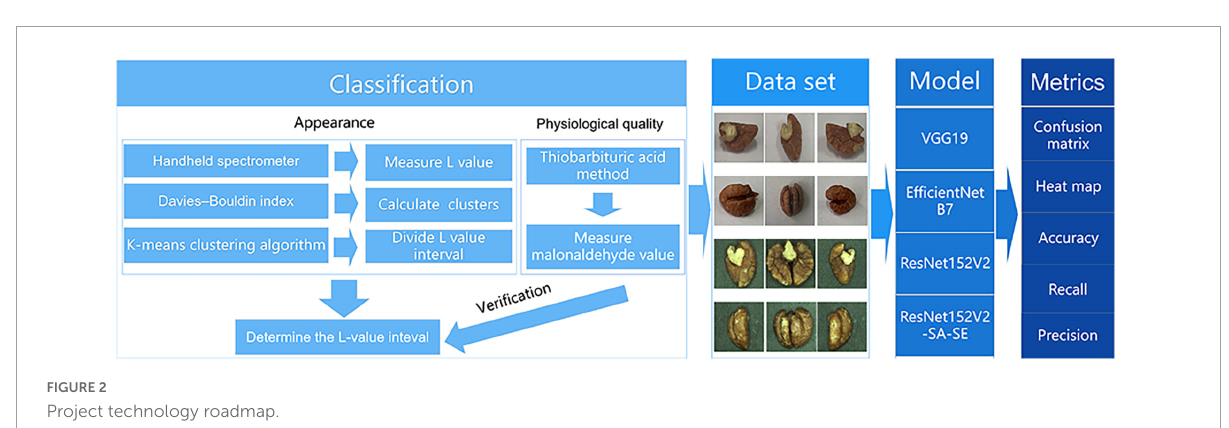
FIGURE2 Project technology